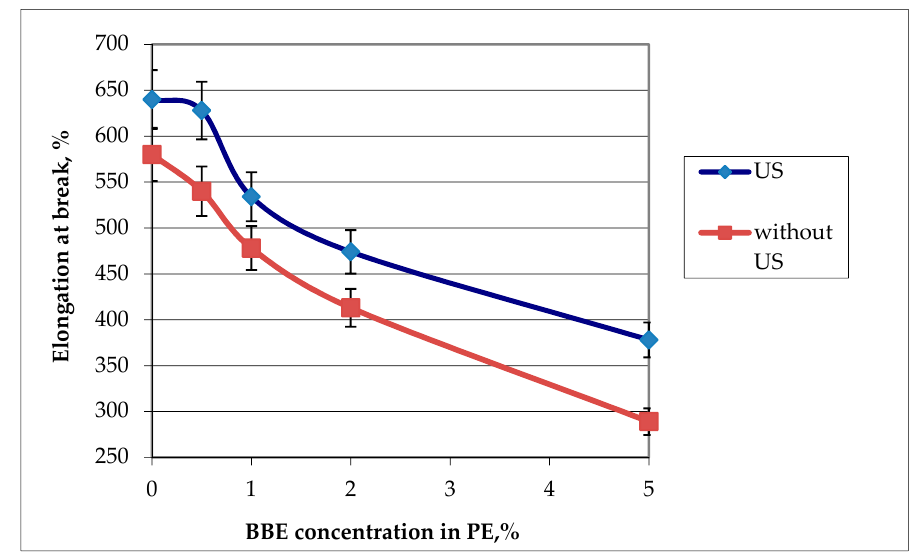
Figure 6. Graphic dependence of the elongation at break on the birch bark extract (BBE) content in polyethylene (PE) and on ultrasonic (US) treatment.